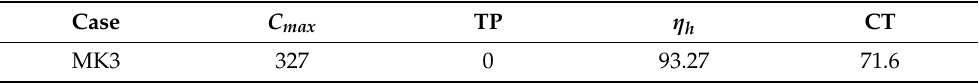
Figure 11 Figure 11. Equipment Gantt Chart for the Corresponding Production Scheduling Results of Case MK3. Table 4. A non-dominated optimization target value and running time of